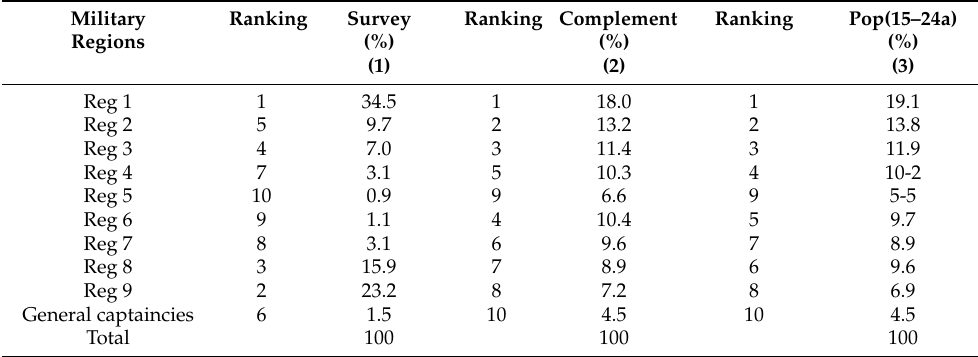
Table 3. Distribution of subjects by place of birth, draft complements, and population between the ages of 15 to 24 in the 1950 population census (Army regions). Military Ranking Survey Ranking Complement Ranking Pop(15–24a) Regions